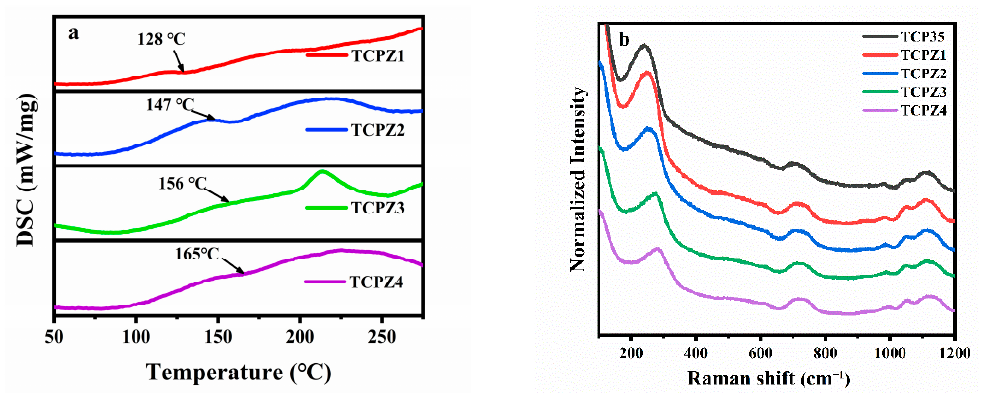
Figure 4. DSC curves ( a ) and Raman spectra ( b ) of TCPZ glasses.